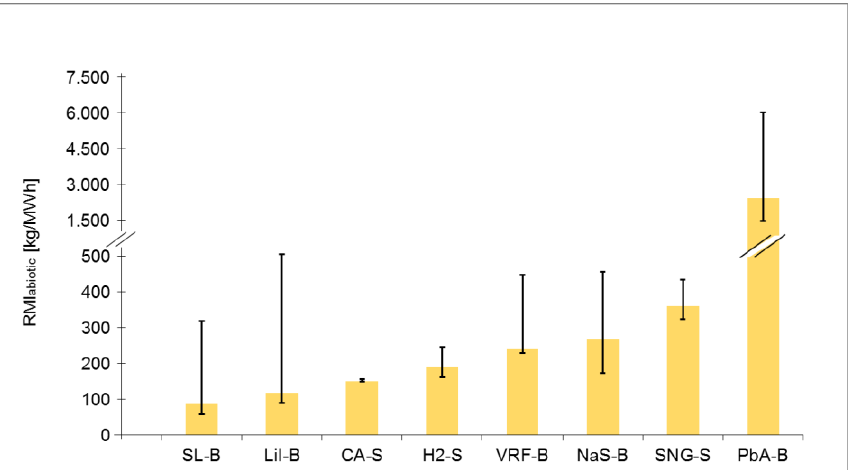
Figure 6. Change in raw material input abiotic RMI abiotic per fed-out electricity for shorter and longer lifetime of electrical energy storage technologies.